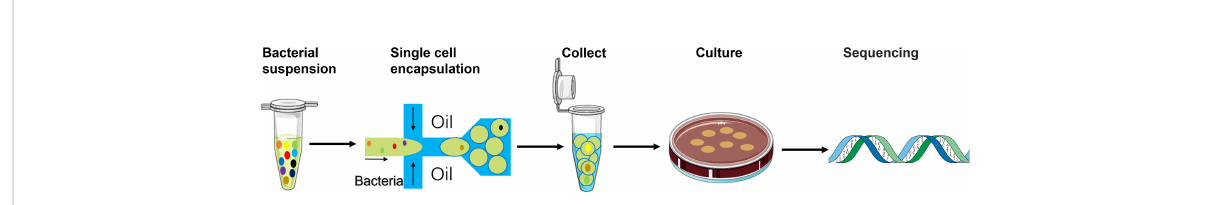
FIGURE 1 Schematic of the work fl ow using the single-cell droplet culture approach to search for functional bacteria from gut microbiota. Faecal samples were dissolved in media to extract gut microbiota into liquid. The pre- fi ltering bacterial suspension was injected into the micro fl uidic device for cell encapsulation in droplets. Stable and uniform droplets were collected into an Eppendorf tube containing mineral oil. Droplets were then spread on a culture plate and would burst eventually. The bacteria in the droplets could continue to grow on the plates. 16S rRNA sequencing technology was applied to identify growth colonies ’ species.